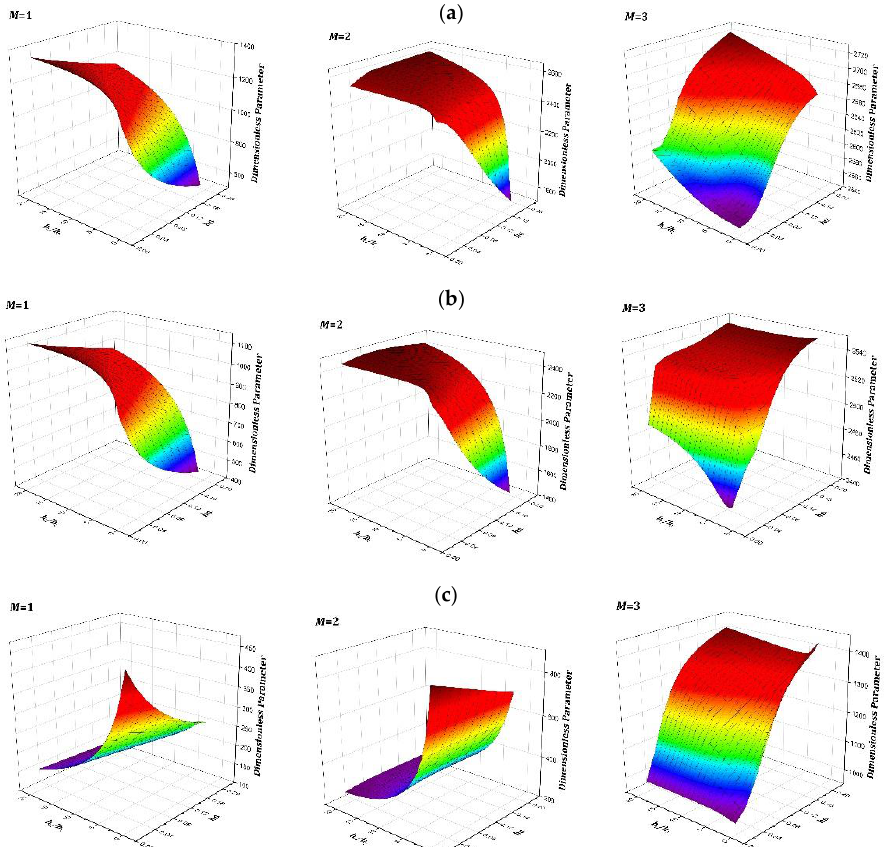
Figure 7. Variation of frequency parameter with various thickness of cylindrical shell and annular plate in LCDCSS. ( a ) CC-CC; ( b ) SS-SS; ( c ) E 1 E 1 -E 1 E 1